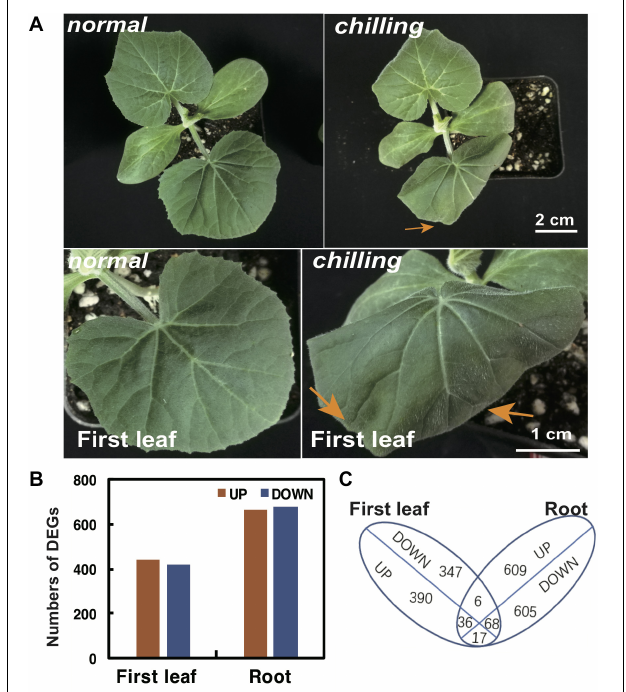
FIGURE 3 | Analysis of differentially expressed genes (DEGs) between leaves and roots of pumpkin after 6 h of chilling. (A) Chilling injury symptoms of the leaves of pumpkin rootstock seedling after 6 h of chilling. Yellow arrows indicated wilted and wrinkled edge of first true leaves. (B) The number of up- and downregulated DEGs in the first leaves and roots of pumpkin compared with those in the 0 h normal condition. (C) Venn diagram of up- and downregulated DEGs in pumpkin first leaves and